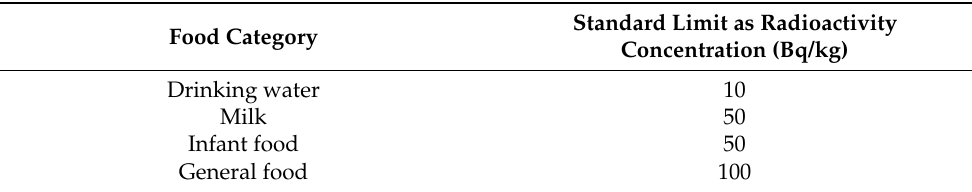
Table 1. Current standard limits for radioactive cesium (sum of 134 Cs and 137 Cs) for foodstuffs in Japan. The standard limits were established on 1 April